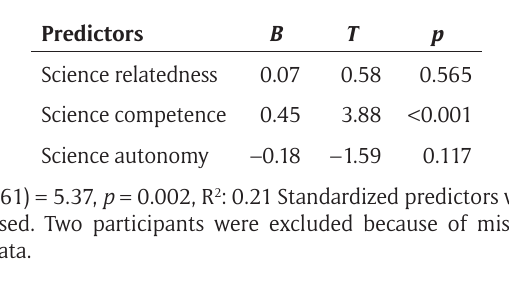
Table 4: Regression analyses predicting changes in par- ticipants’ future intentions to participate in